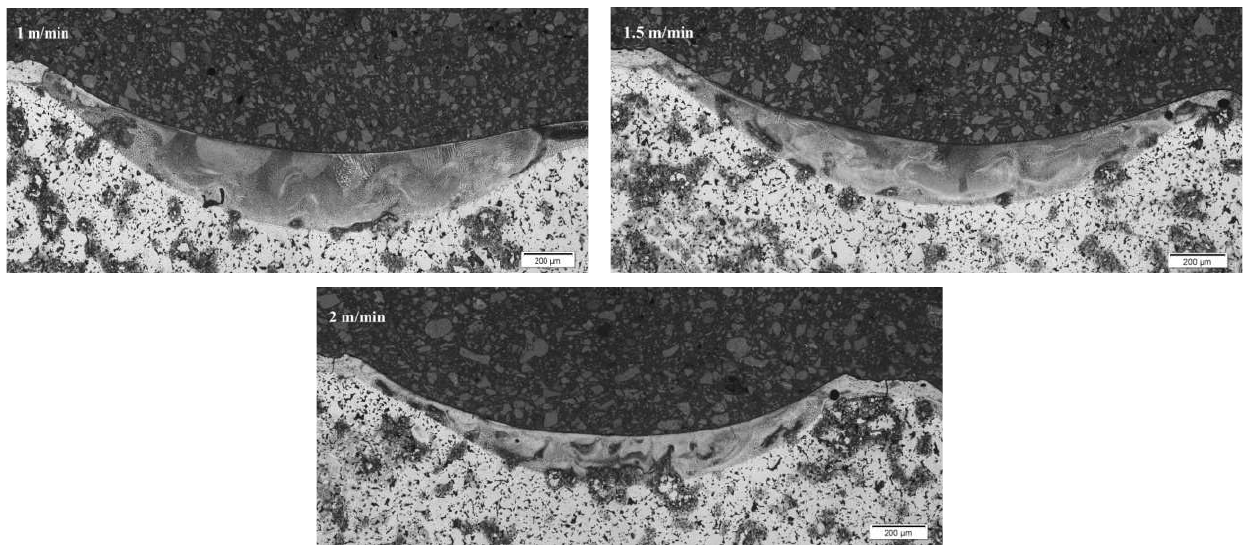
Figure 8. Cross-section of the entire alloyed zone for sample 2.